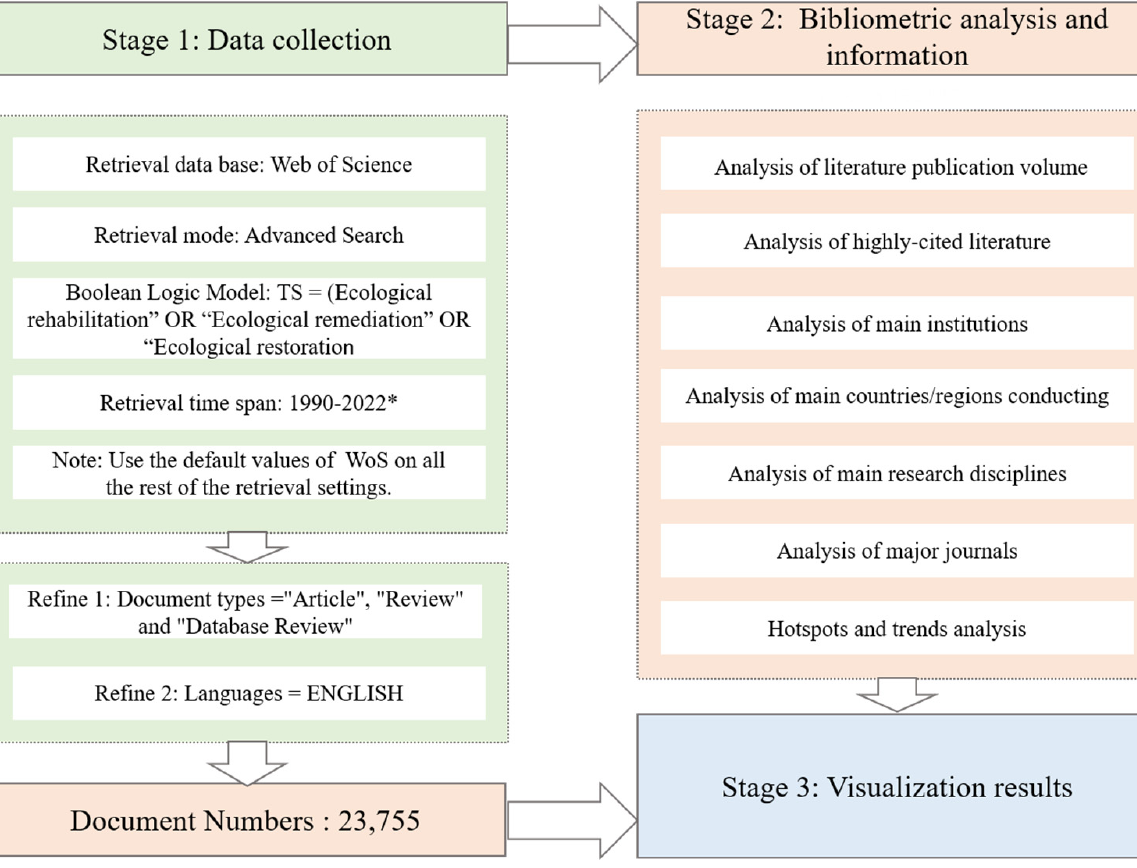
Figure 1. Bibliometrics process in the field of ecological restoration. (* as of 31 August 2022).